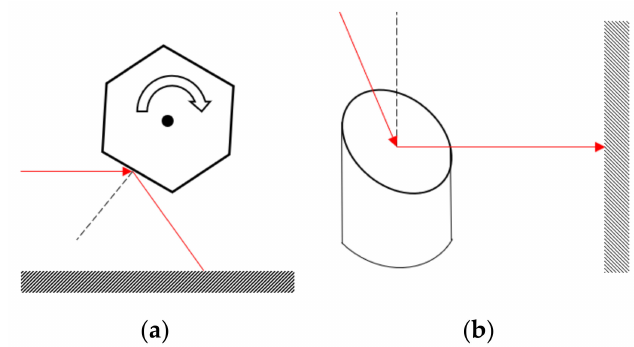
Figure 7. Illustration of 2D optomechanical scanning using ( a ) polygon mirror ( b ) o ff -axis parabolic mirror.